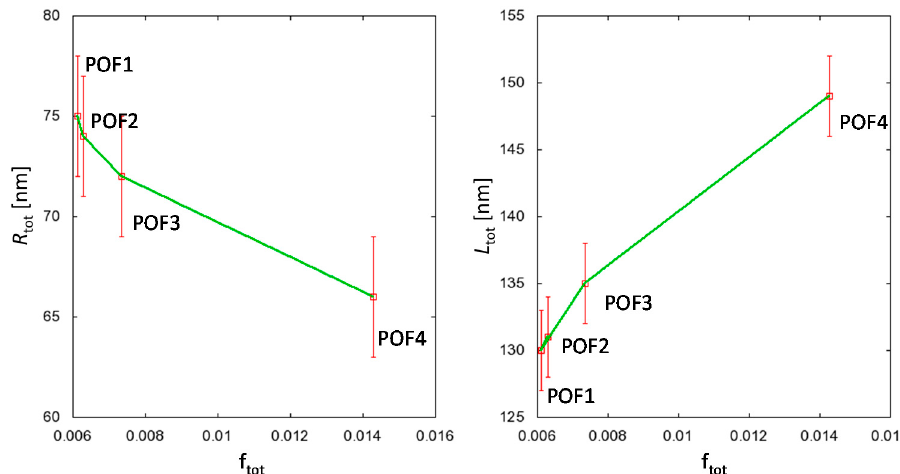
Figure 9. Dependence of the integral equatorial and meridional parameters R tot ( left ) and L tot ( right ) on the overall process-parameter f tot . Although the major differences in the structure parameters are induced by the mechanical draw ratio, the impact of small changes in the spin-draw ratio between POF1 and POF2 is also noticeable.